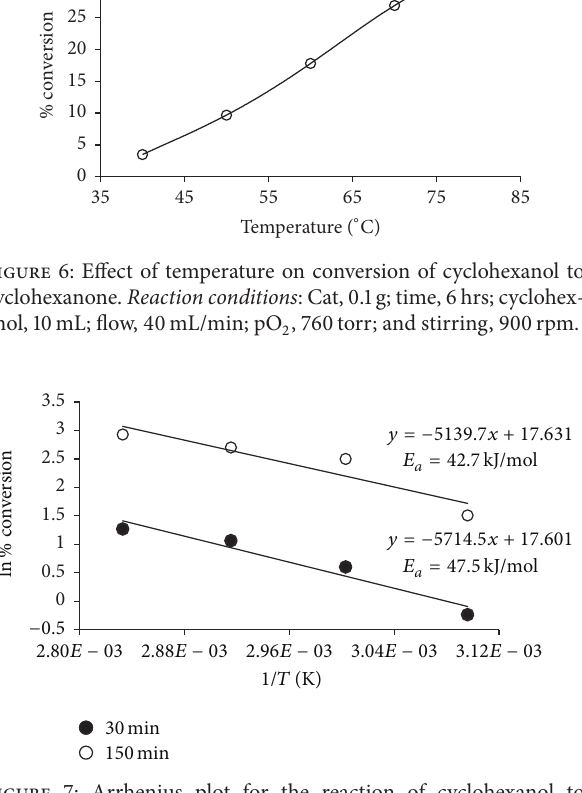
Table 1: Oxidation of cyclohexanol to cyclohexanone by molecular oxygen.